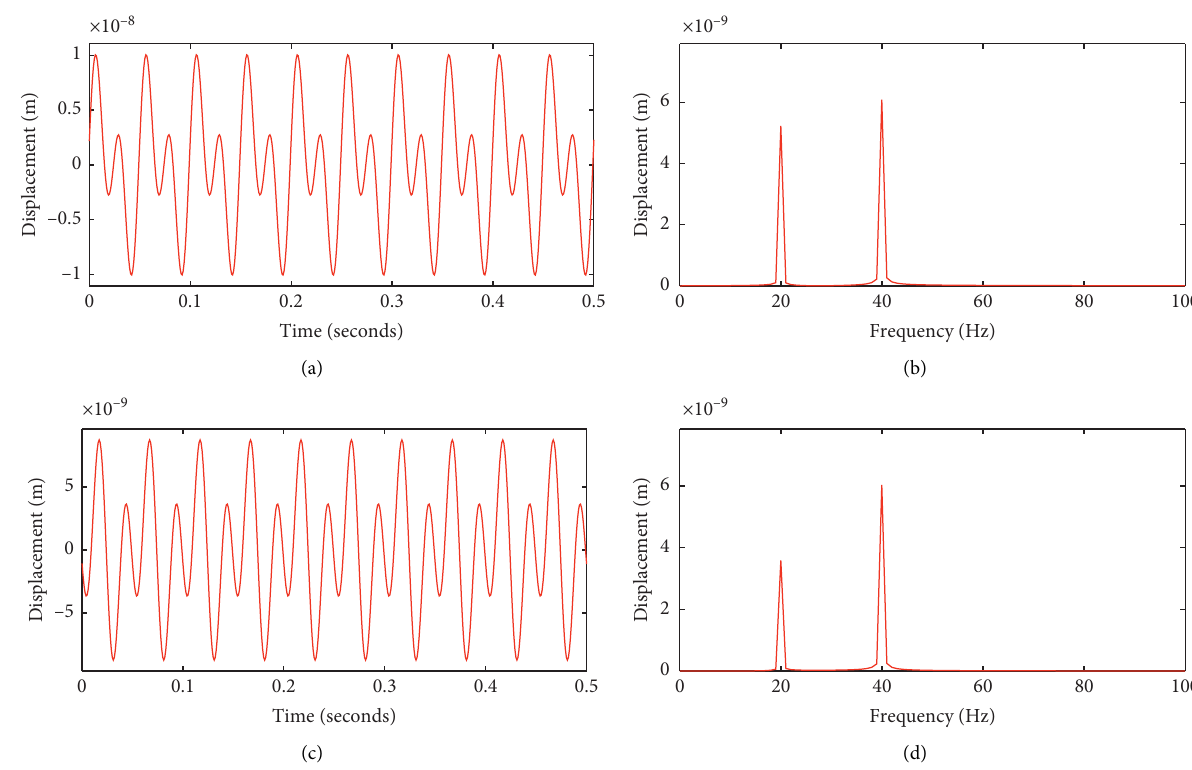
Figure 11: Time- and frequency-domain response of unbalance and parallel misalignment fault in the x directions ( x response of x1. (b) Frequency response of x1. (c) Time response of x2. (d) Frequency response of x2.